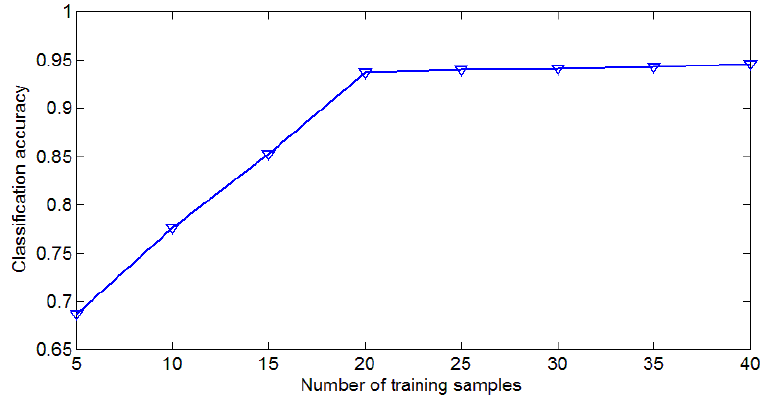
Figure 24. Overall accuracies using different number of training samples in WHU-RS dataset.